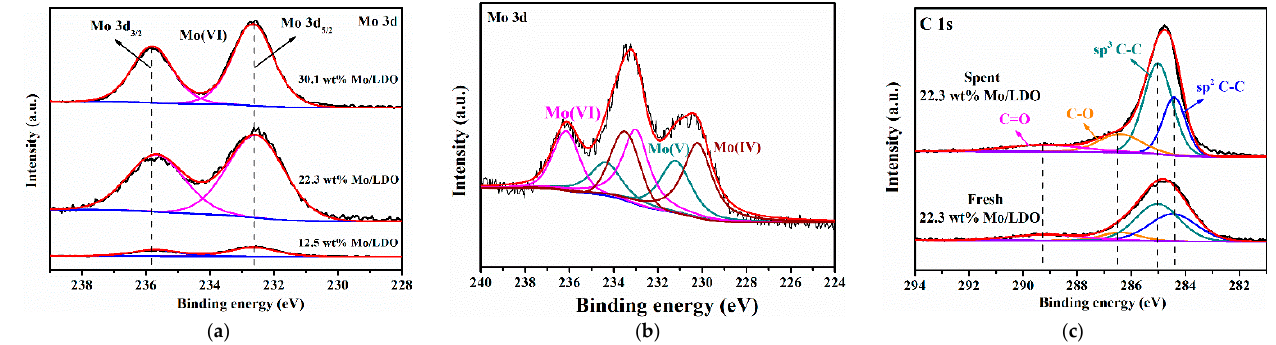
Figure 8. ( a ) Mo 3d XPS spectra of fresh Mo/LDO catalysts; ( b ) Mo 3d XPS spectra of used 22.3 wt% Mo/LDO catalyst; ( c ) C 1s XPS spectra of fresh and used 22.3 wt% Mo/LDO catalyst. Table 2. Binding energies (eV) and atomic ratios of Mo/(Mg + Al) determined by XPS. Sample Mo 3d 5/2 Mo 3d